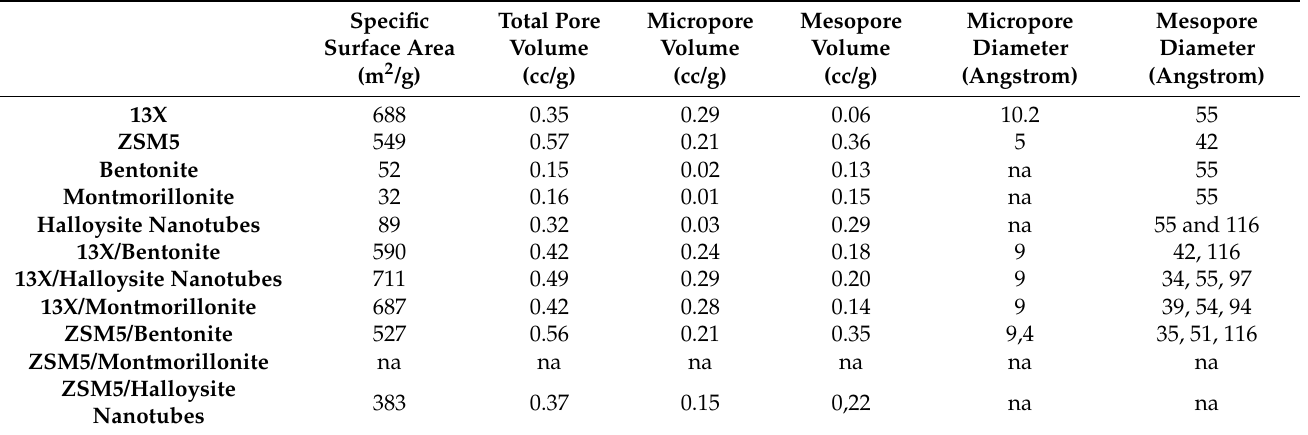
Table 2. Special surface area, pore volume and size of novel 3D-printed biocarriers compared to the values of the original materials.